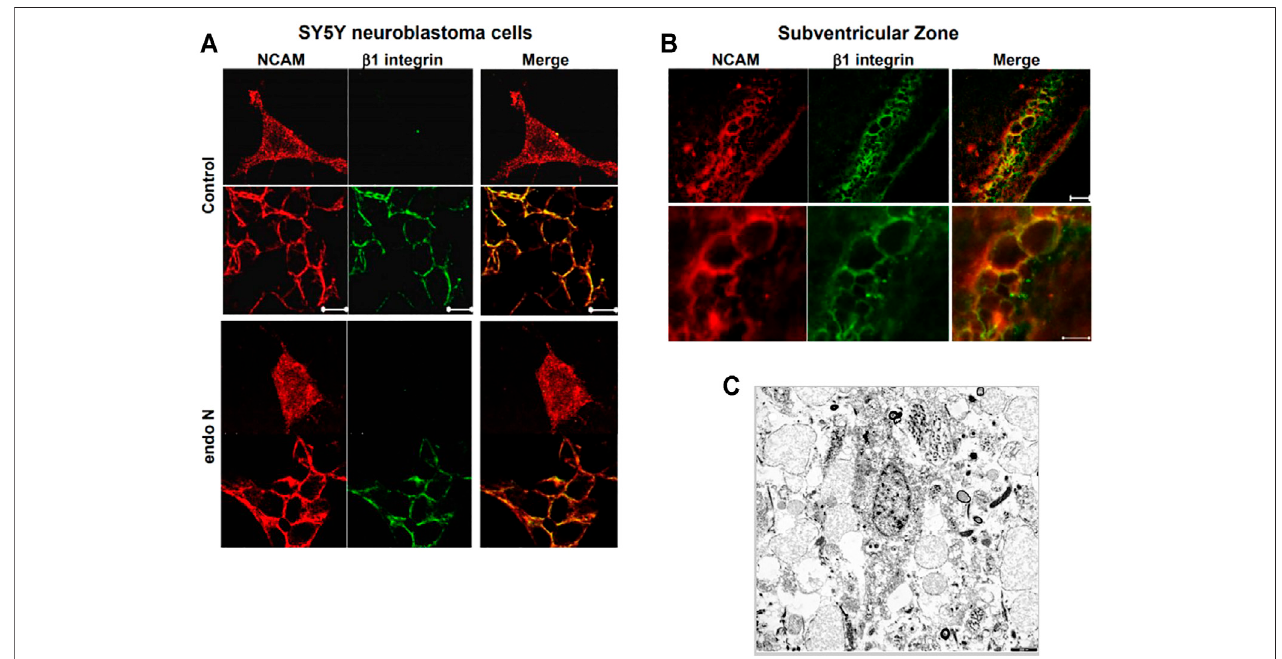
FIGURE 10 | The relation between NCAM and β 1-integrinin neuroblastoma cells was performed by an immune staining for both molecules. In the absence and presence of endo N, NCAM colocalized with β 1-integrin (A) . This colocalization was present at regions where no cell – cell contact occurred and was independent of the presenceofendoN (B) . β 1-integrinwasnotexpressedinisolatedcells,whereasNCAMwasexpressed,butwaspresentalloverthecell.Inthecaseofcell – cellcontacts, NCAM was localized on thecell surface and β 1-integrinwasexpressed incontact areas betweenthe cells, asindicatedin (B) for thesub ventricular zone (SVZ). (C) shows cells of a glioblastoma multiform WHO grade 4 (9). In these kind of tumors speci fi c integrin-interactions are also of highest